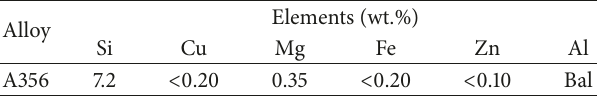
Table 1: Chemical composition of the base A356 alloy. Elements (wt.%) Alloy Si Cu Mg Fe Zn Al A356 7.2 < 0.20 0.35 < 0.20 <